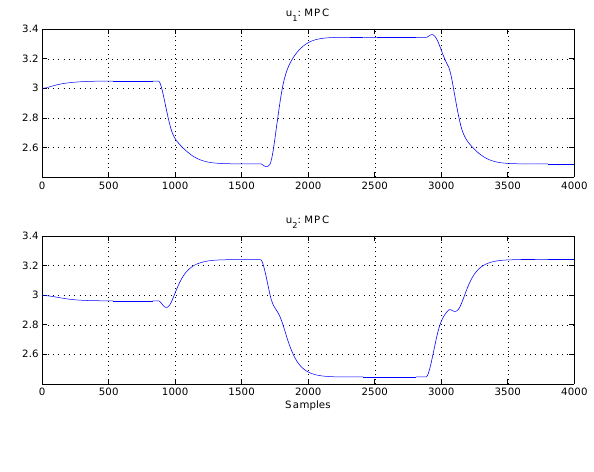
Figure 2: Simulation of the quadruple tank process and the minimum phase case in Example 6.1 with MPC control with integral action. Control inputs illustrated. Prediction horizon L = 100 and control horizon L u = L